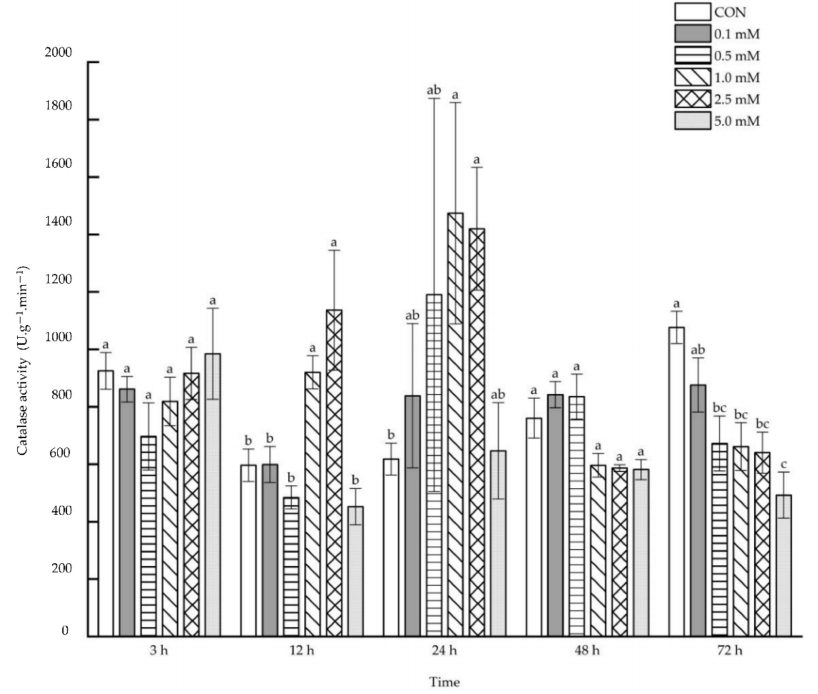
Figure 11. The systemic effect of the SA concentration and post-treatment time on the catalase activity in roots following exogenous foliar application. The data are presented as mean ± standard errors. The significance of data was determined by the Duncan method. The difference between different letters at the same time reached significant levels of